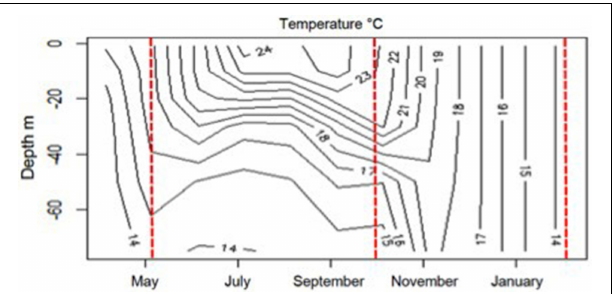
FIGURE 1 | Vertical distribution of temperature ( ◦ C) in the 0–70m depth layer between April 2011 and February 2012 at Bay of Villefranche sur mer (data SOMLIT, http://somlit.epoc.u-bordeaux1.fr/fr/). The red lines correspond to the day when the water was collected in May, October, and